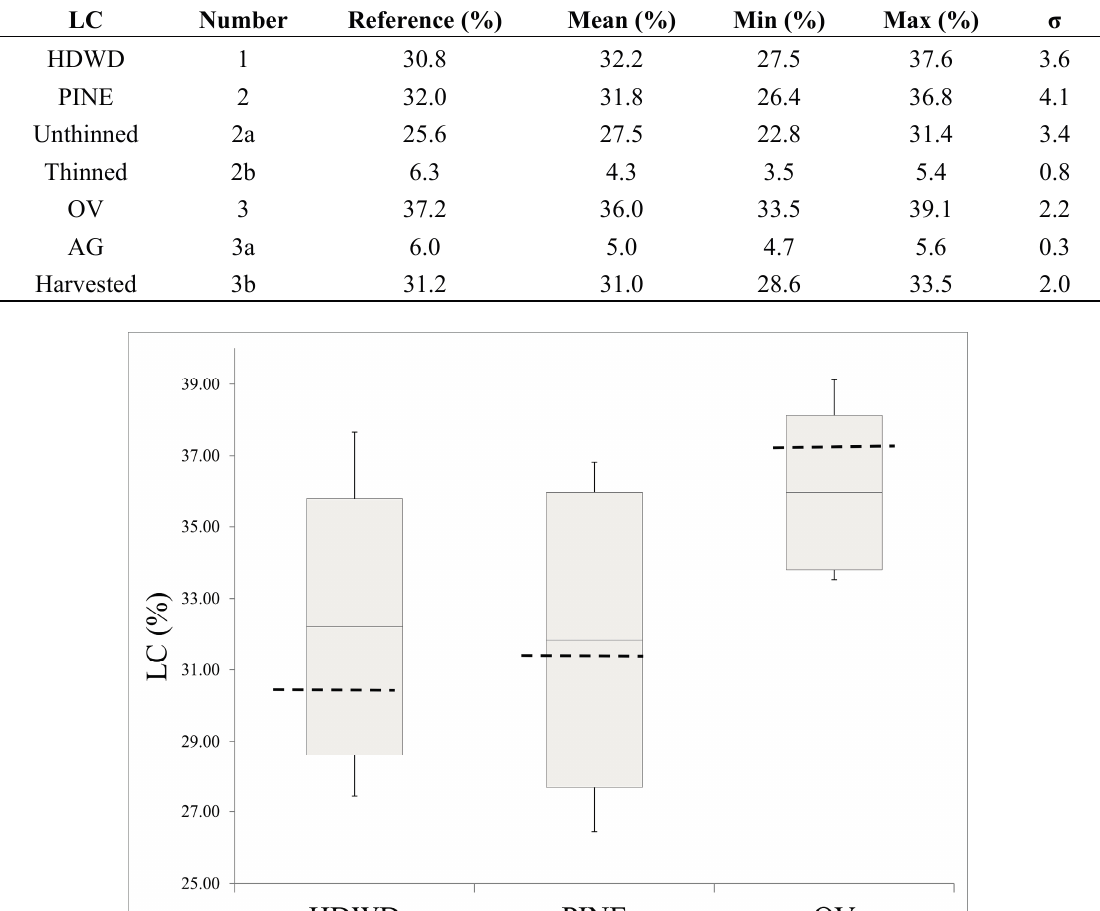
Table 1. Analyst variation from classification of the 1-km 2 area at EPA_Appomattox (OV—Other Vegetation; AG—Agriculture).